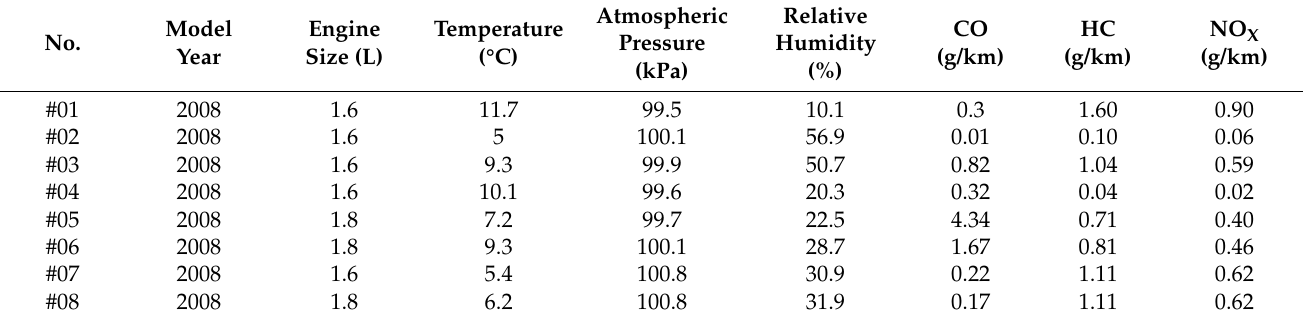
Table 1. Regulated emissions for fifty